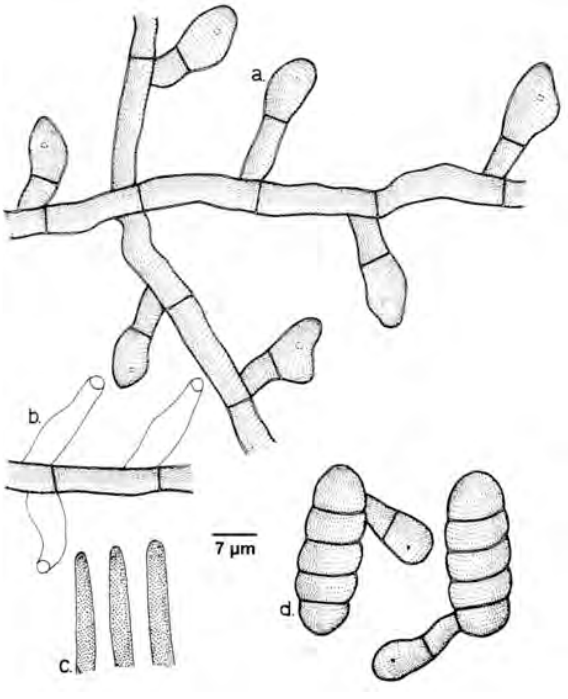
Figure 89. Meliola ligustricola a - Appressorium; b - Phialide; c - Apical portion of mycelial